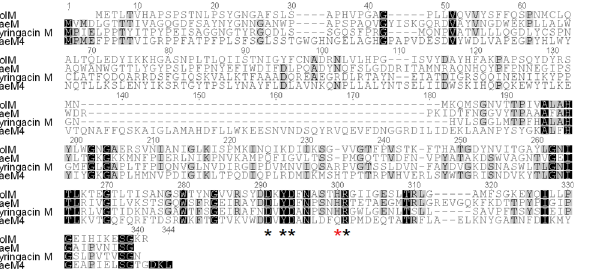
Fig 2. Clustal W alignment of E . coli ColM, P . aeruginosa PaeM, syringacin M and PaeM4 amino acid sequences. Residuesessentialfor activity of ColM [19] are marked by asterisks; residuesessentialfor activity of PaeM [20] are marked by black